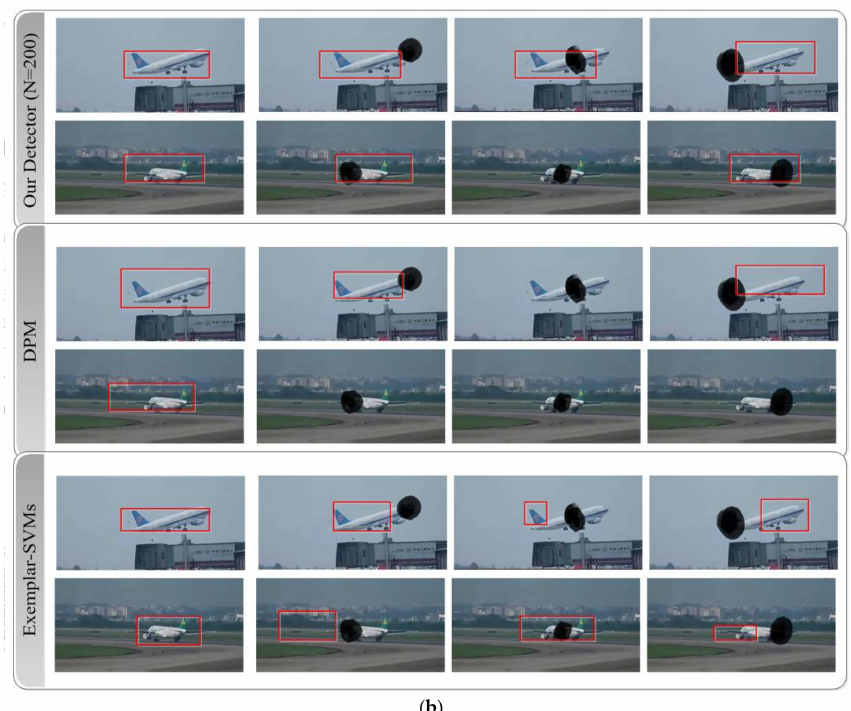
Figure 9. ( a ) Detection results of partially-occluded aircrafts in original images; and ( b ) detection results of the aircrafts with manual occlusion in different parts (nose, body, and tail).